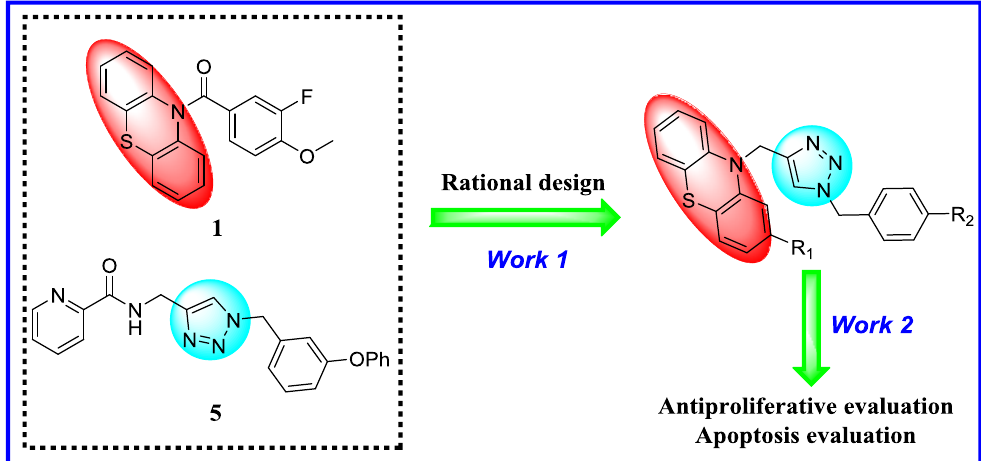
Figure 3. Rational design of target compounds as novel antitumor agents.